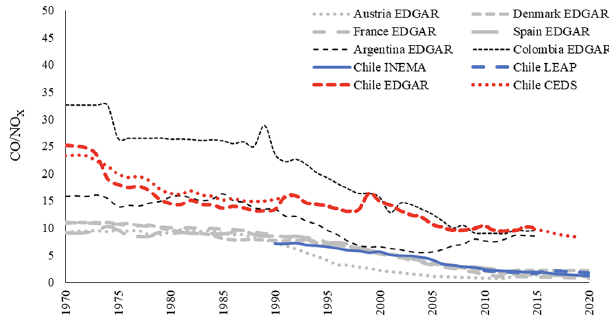
Figure 11. CO / NO x ratios for Chile and different countries from EDGAR and this work. External data obtained from the models EDGAR, CEDS and